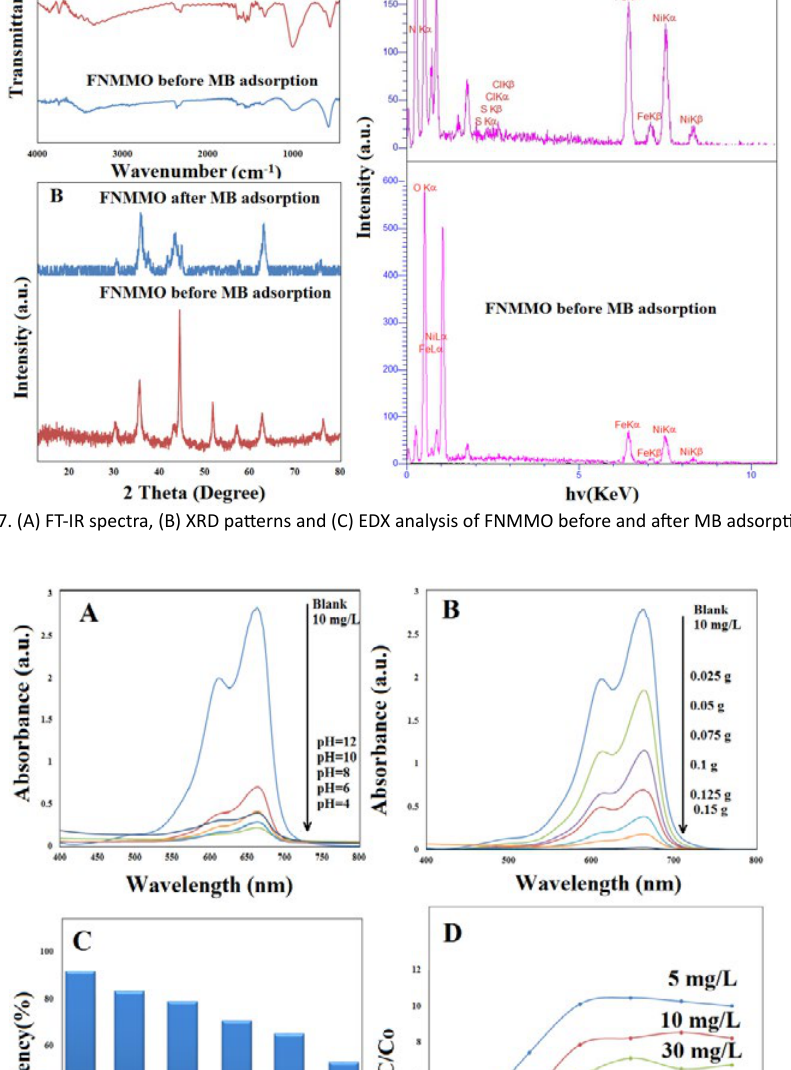
O /NiO in presence of various 3 4